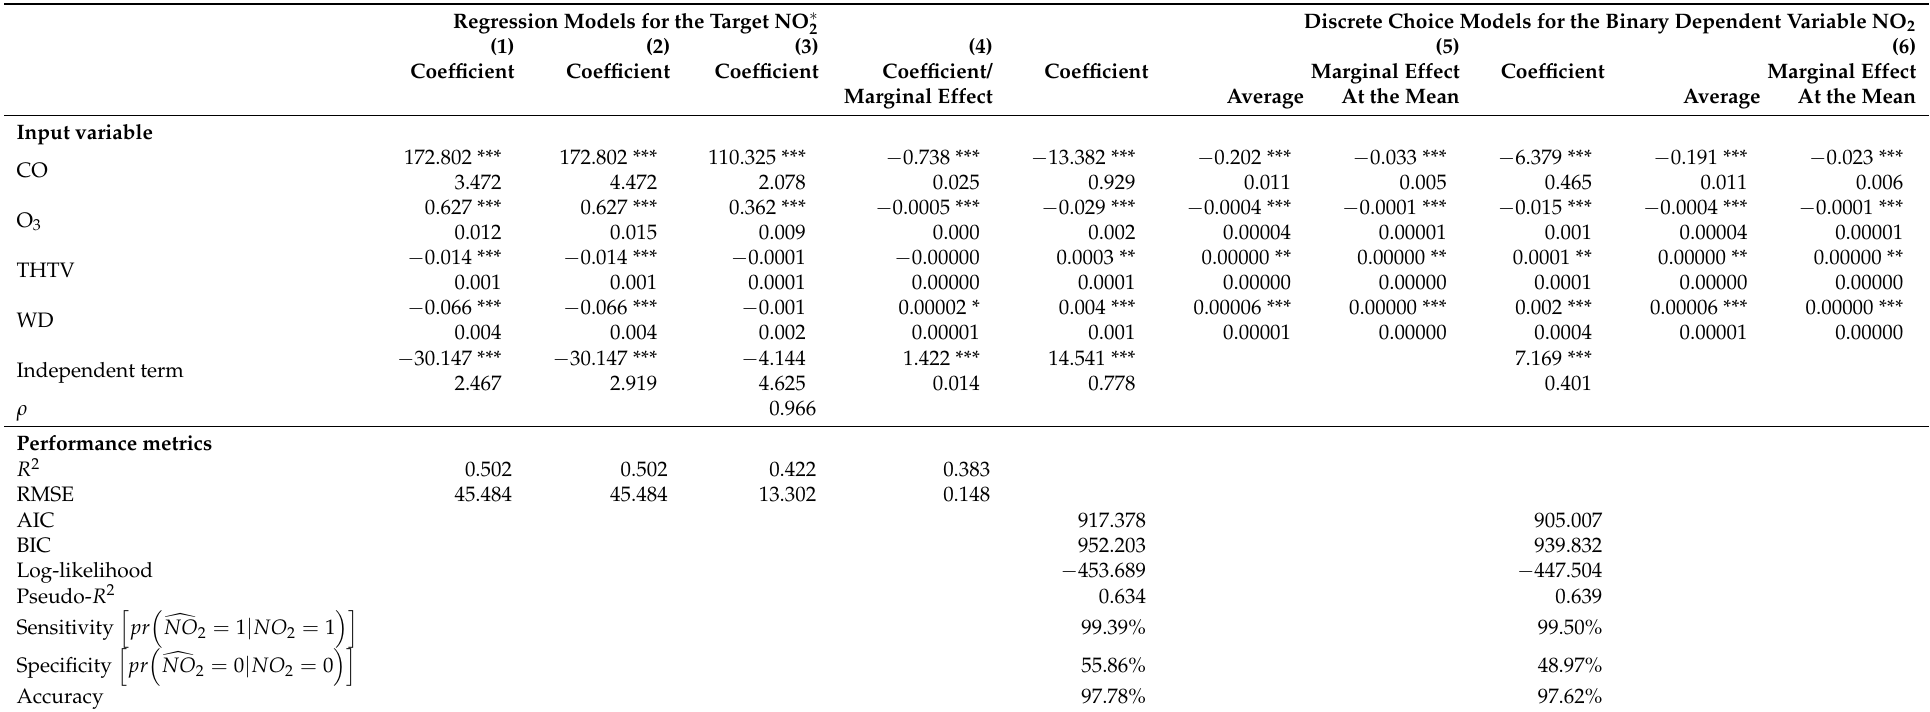
Table 5. Main results of the classification